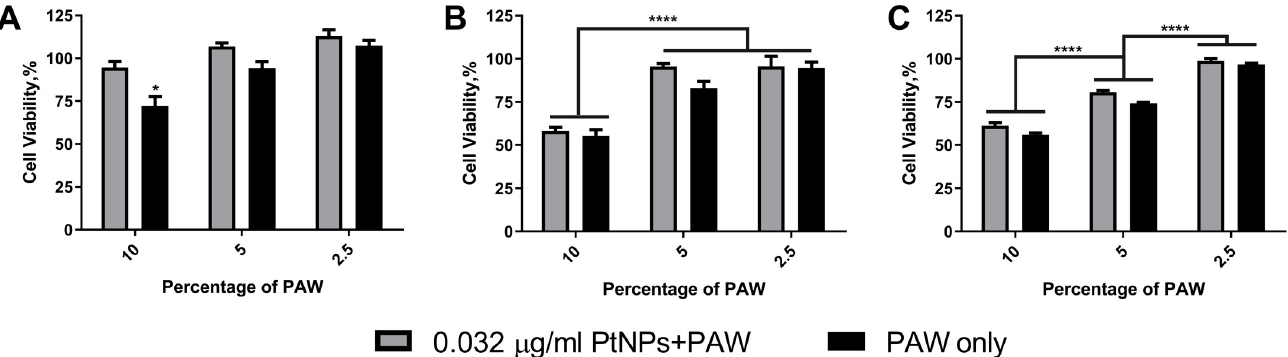
Fig 6. Time points assay for PAW. U-251 MG cells were incubated with 0.032 μ g/ml PtNPs for 24 h and then treated 2.5, 5 and 10% PAW and incubated for 2 h (A) , 4h (B) and 24h (C) .